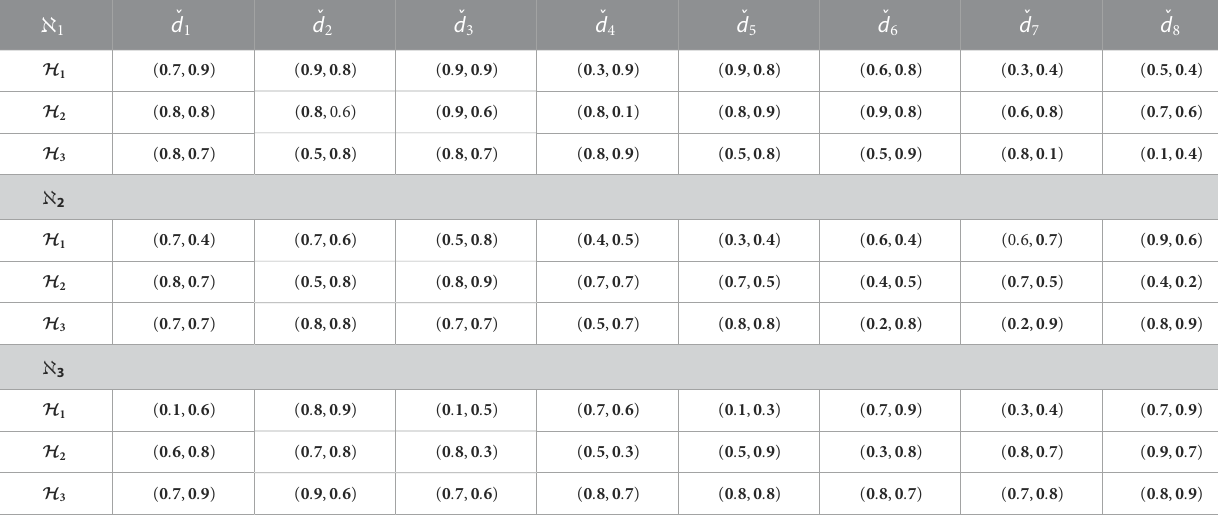
TABLE 1 Decision matrices for alternatives.